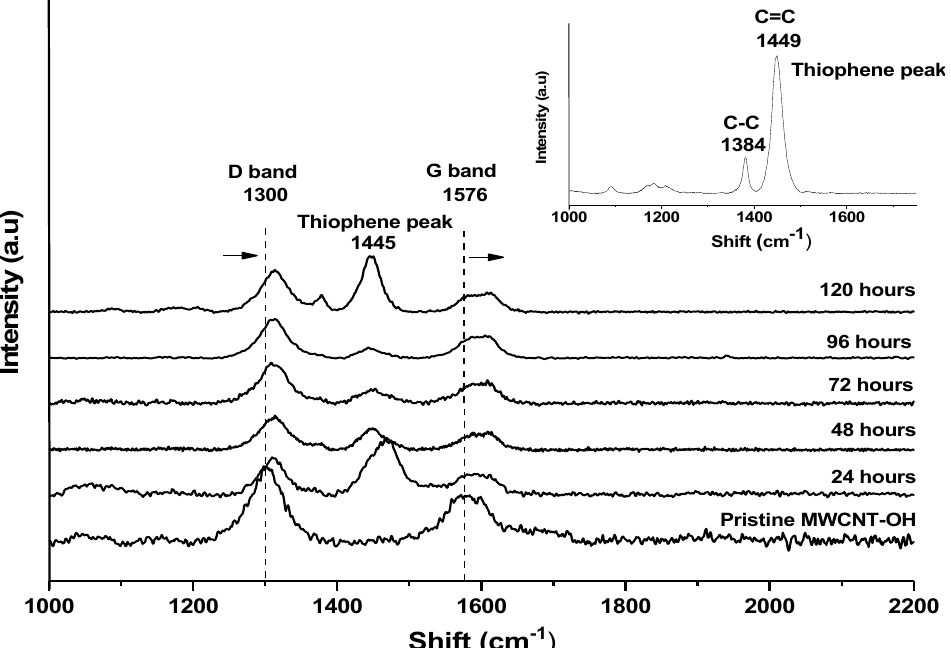
Figure 2. Raman spectra of ( a ) pristine P3HT, ( b ) pristine MWCNT-OH and P3HT/MWCNT-OH nanocomposites prepared at different reaction times.